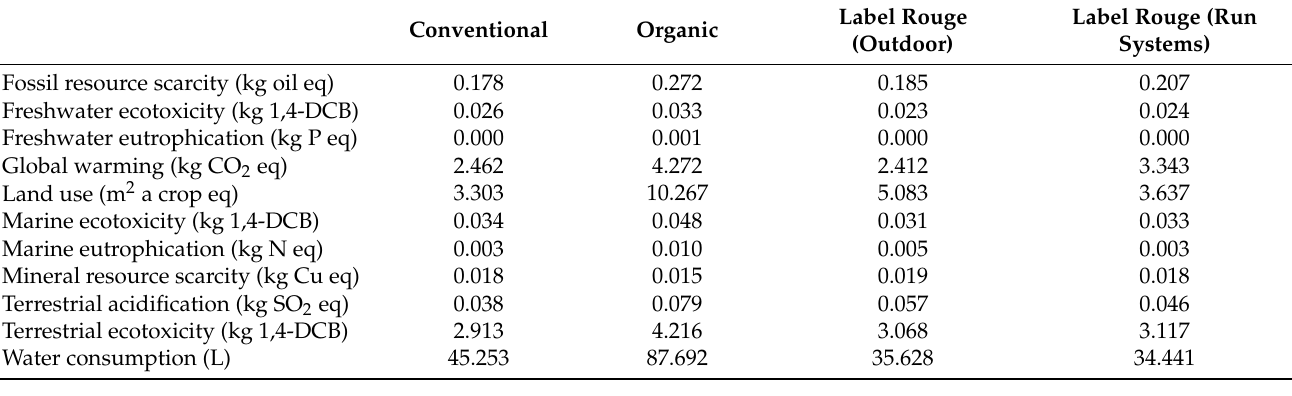
Table 2. Pig meat environmental impact per unit production (kg) across organic, Label Rouge and Conventional systems: Data obtained from AGRIBALYSE ® database and computed using OpenLCA 1.10.2 [35,36].